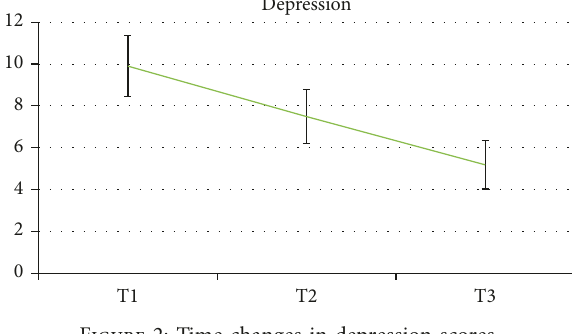
Figure 2: Time changes in depression scores.